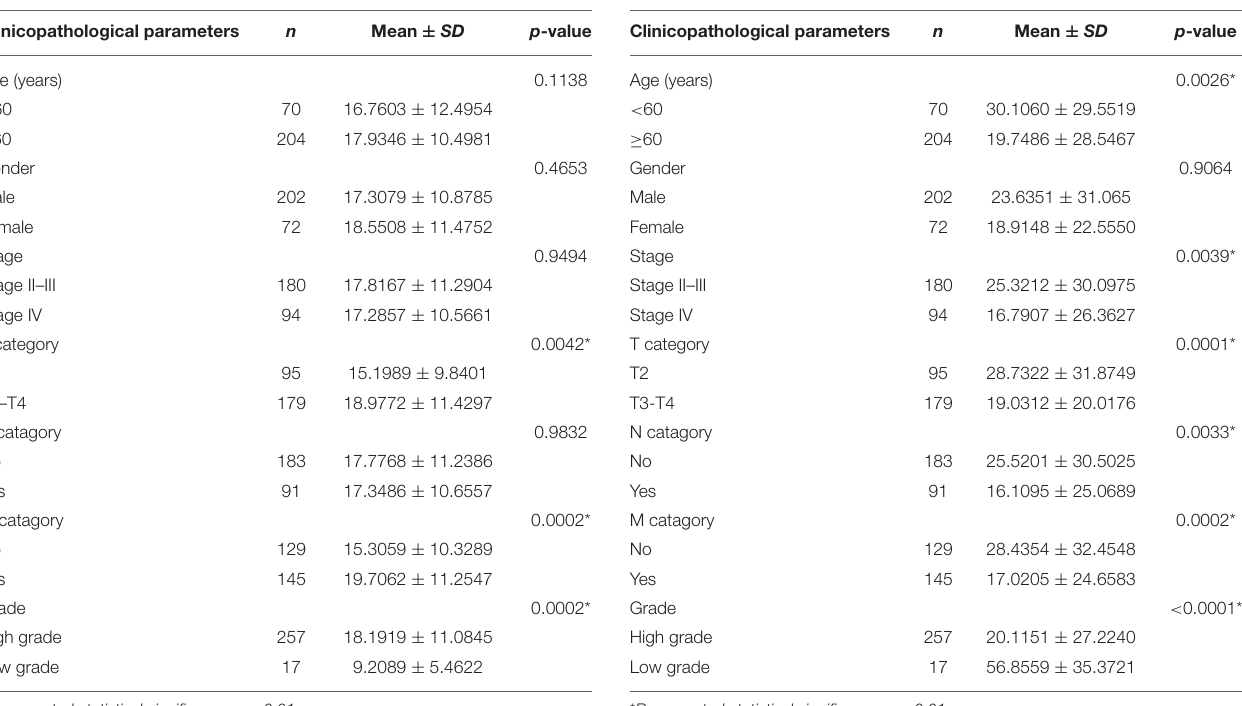
* Represented statistical significance p <